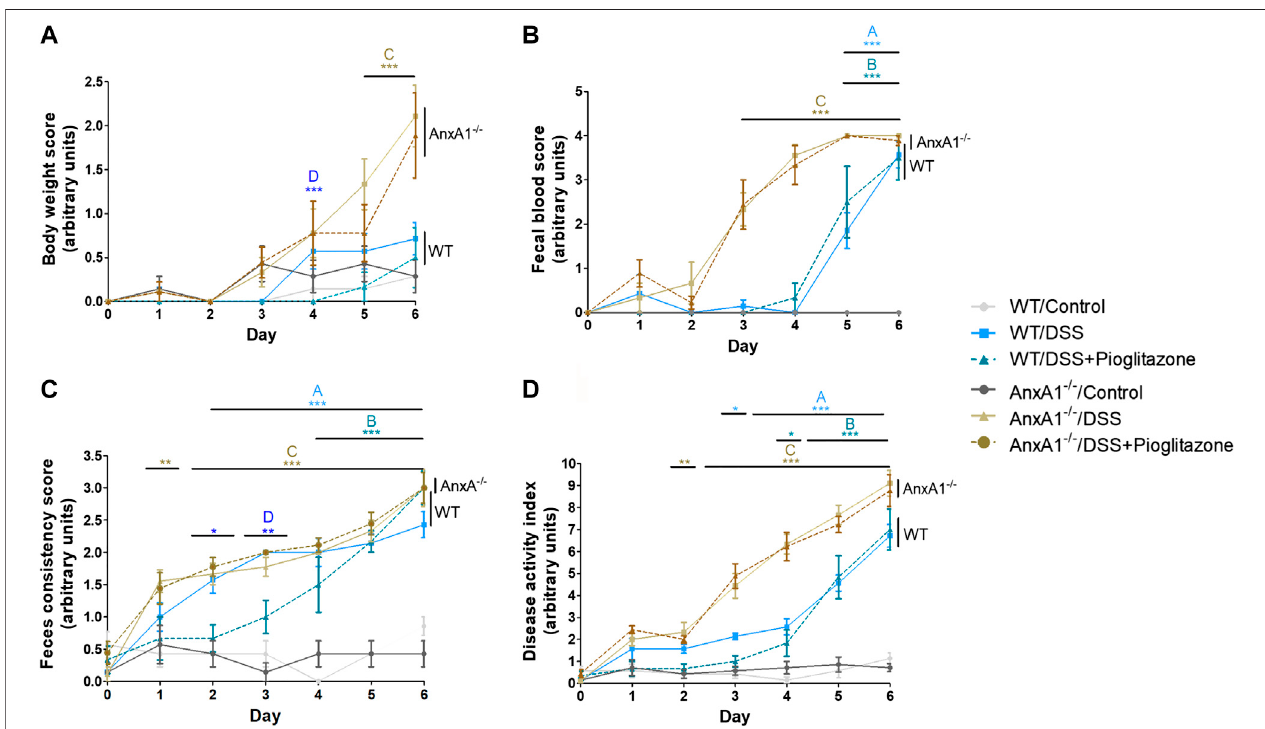
FIGURE1| Clinical parameters throughout progressionofexperimental colitis.Experimentalcolitiswasinduced inwildtype or AnxA1 − / − mice viaingestion ofDSS and mice were treated with pioglitazone daily at a 10 mg/kg dose for a 6 days period. Throughout the development of the experimental model, loss of body weight (A) , rectal bleeding (B) and feces consistency (C) were assessed daily, resulting in the disease Activity Index (D) . *, **, *** p < 0.05, 0.01, 0.001 in comparison to another groupasspeci fi edbythelettersaboveeach curve:A:WT/ControlxWT/DSS; B:WT/ControlxWT/DSS+Pioglitazone;C:AnxA1 − / − /Control xAnxA1 − / − /DSSand/ or AnxA1 − / − /DSS + Pioglitazone; D: WT/DSS x WT/DSS + Pioglitazone. Data were statistically analyzed using Two-Way ANOVA followed by Bonferroni post-test ( n (cid:2) 6). Results are expressed as mean ± SE.